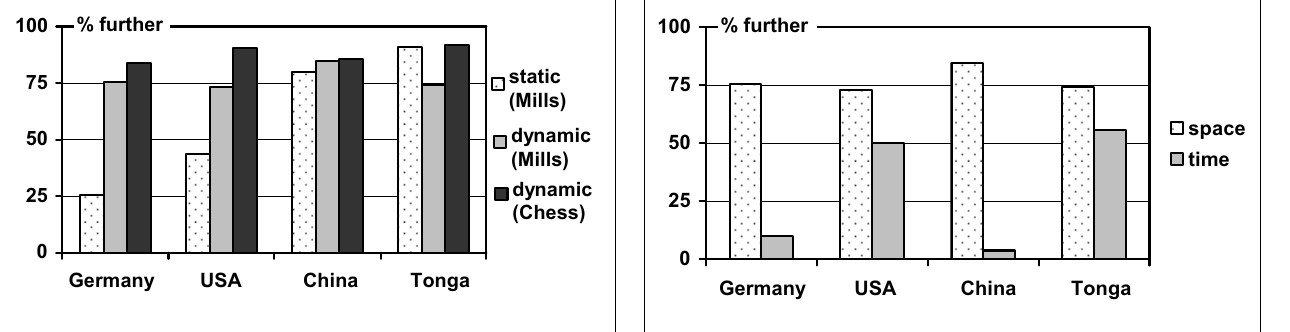
in the temporal tasks split almost evenly between absolute (38%) and intrinsic (36%), as defined in Table 1 (i.e., participants either gave pastwards or futurewards responses, respectively 9